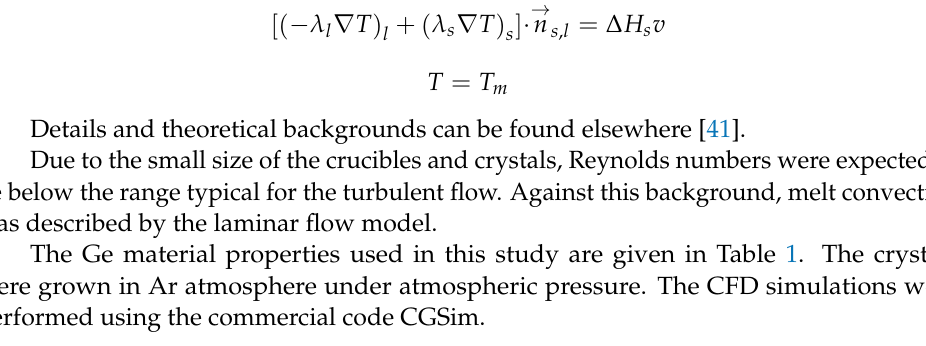
Table 1. Material properties of Ge melt and